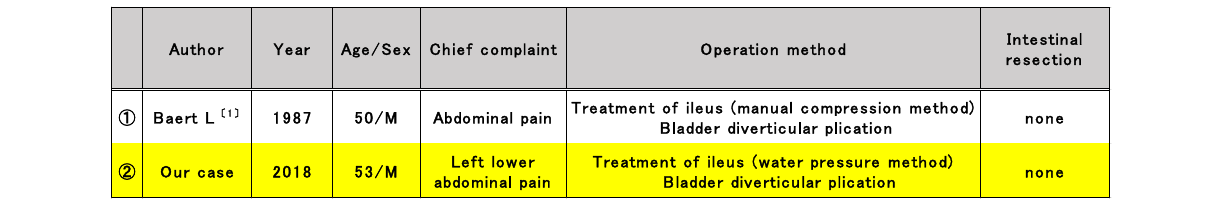
Table 2 Case report of small intestinal ileus impacted in a reversed bladder